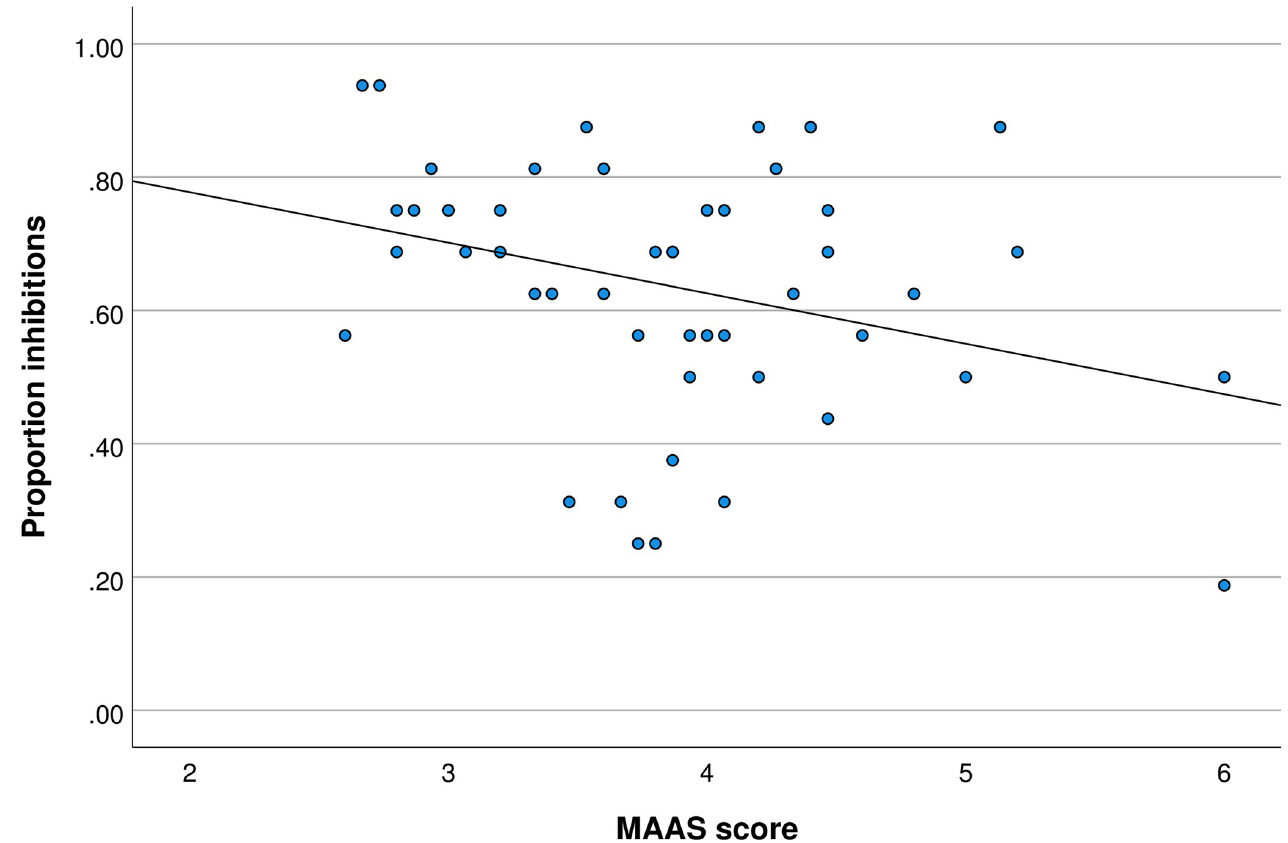
Fig 2. MAAS score and proportion inhibitions in the faces